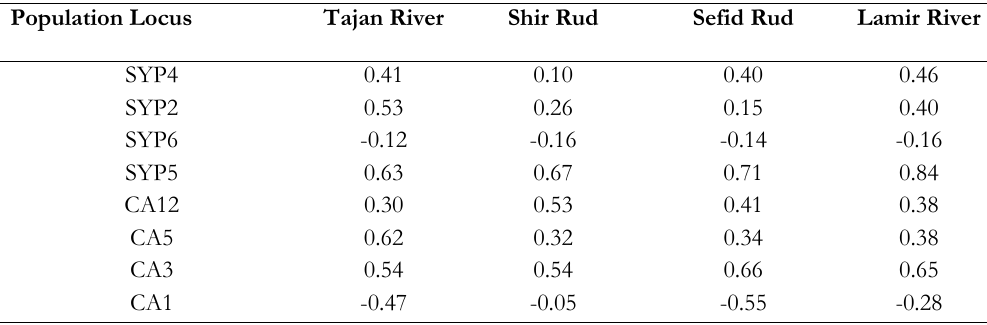
values below st